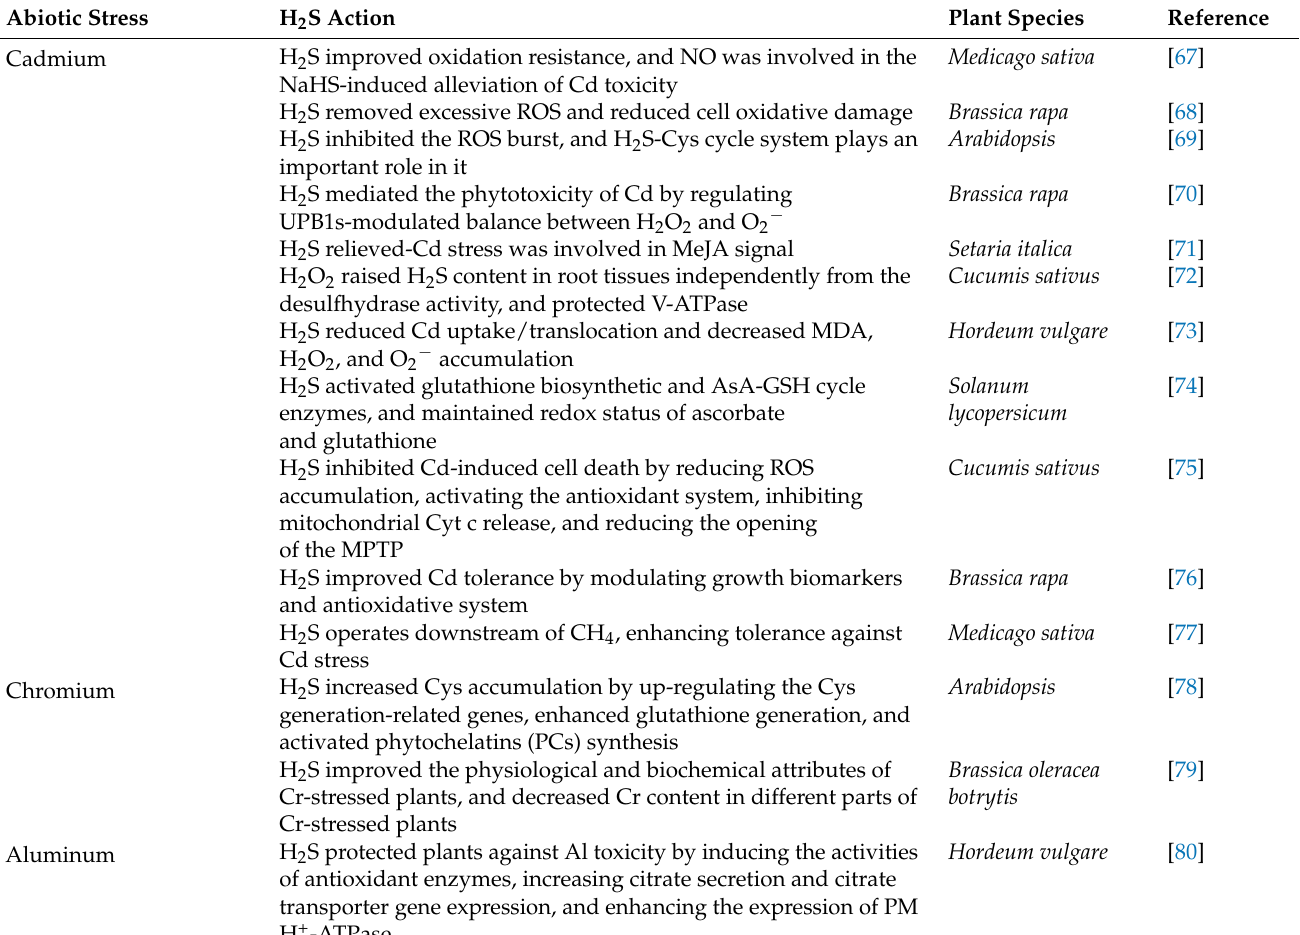
Table 2. Hydrogen sulfide promotes root growth and its regulation mechanism under abiotic